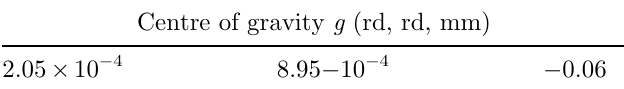
Table 4. Components of center of gravity of spread of production.